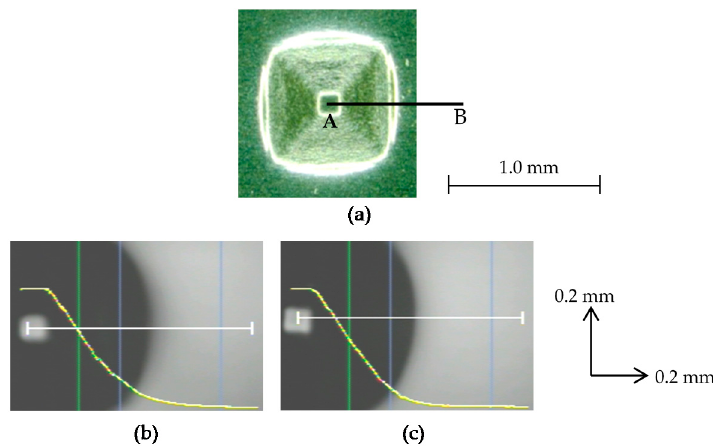
Figure 12. Profiles of pyramids of stainless steel foil under different conditions: ( a ) top view of a pyramid formed without ultrasonic vibration and heating; ( b ) surface profile along AB in the case of NV and NH; ( c ) surface profile along AB in the case of V and H.